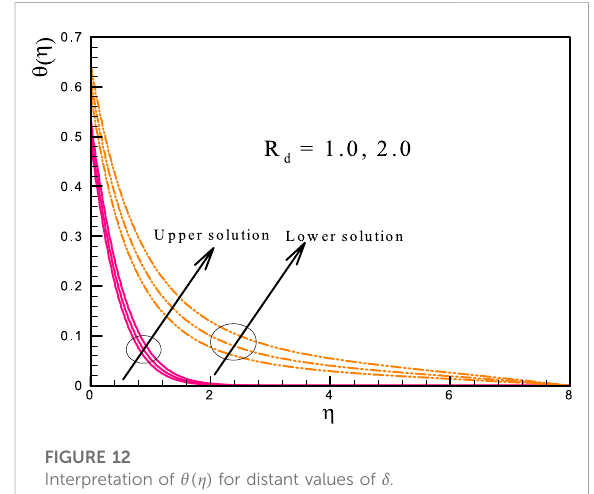
FIGURE 12 Interpretation of θ ( η ) for distant values of δ .